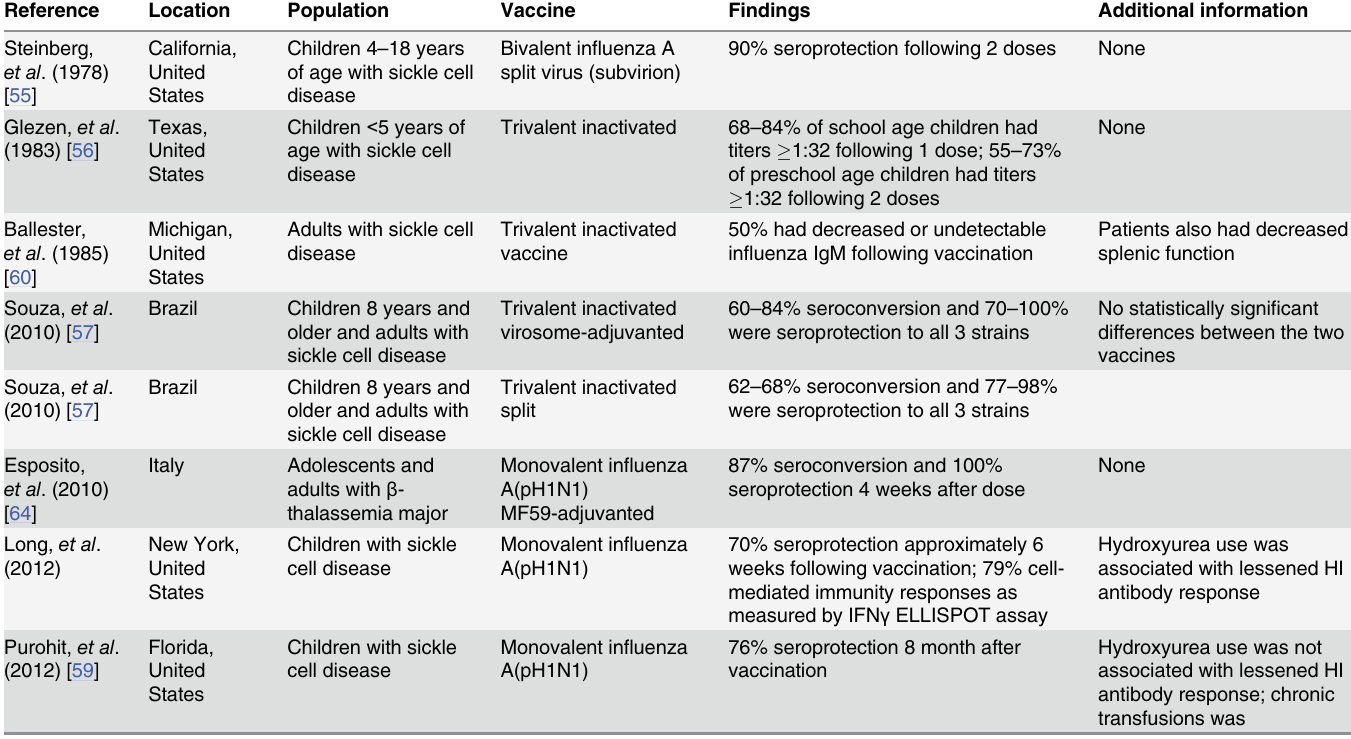
Table 2. Summary of studies evaluating influenza vaccine among individuals with hemoglobinopathies. Seroprotection was defined as > 1:40 HI